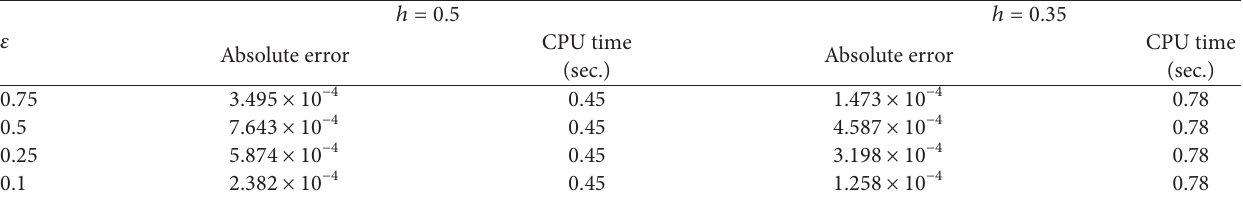
Table 3: The associated errors for several values of 𝜀 for VG.